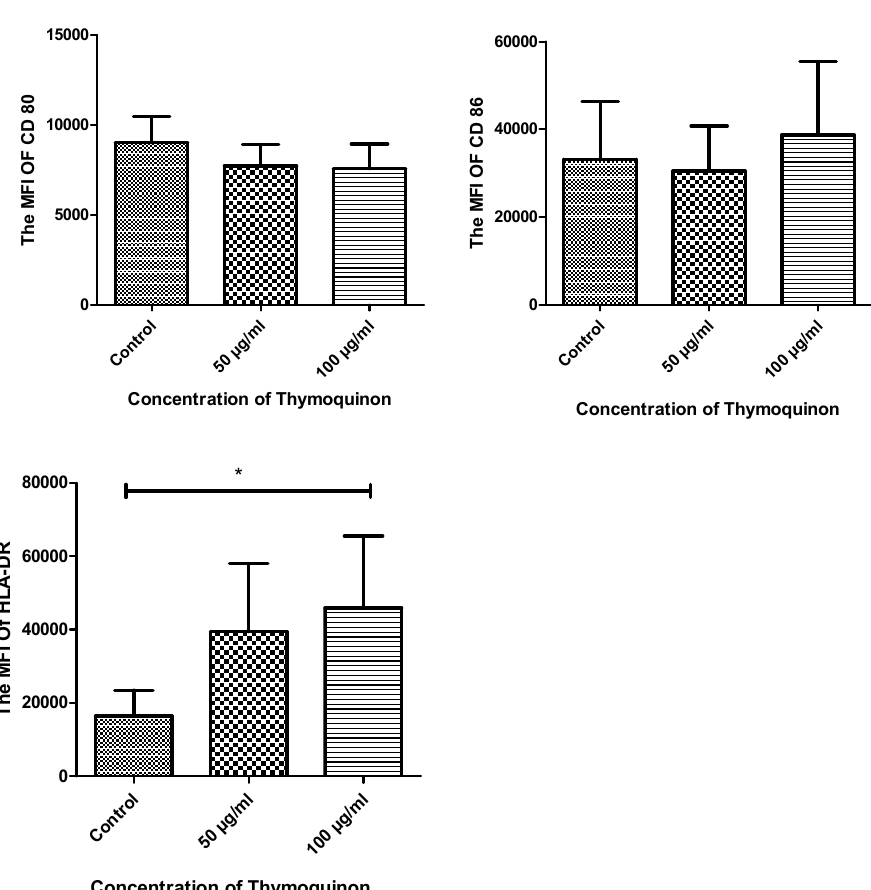
Figure 6. The MFIs of CD80, CD86 and HLA-DR expression in the three groups. The expression of cell-surface molecules on macrophages in different conditions (untreated macrophages (control), 50 µ g/mL TQ-treated macrophages and 100 µ g/mL TQ-treated macrophages) was checked using extracellular staining with CD80-PE, CD86-PE and HLA-DR APC. The TQ-treated cells showed no significant difference for both CD80 and CD86. However, a significant increase in the expression of HLA-DR compared to control was detected with the 100 µ g/mL-treated cells. p value = 0.05 and n = 5. MFI, mean fluorescence intensity; CD80, cluster of differentiation 80; CD86, cluster of differentiation 8; HLA-DR, human leukocyte antigen DR isotype; CD86 PE-A, phycoerythrin monoclonal anti cluster of differentiation 86; HDLA-DR APC-A, allophycocyanin monoclonal anti cluster of differentiation human leukocyte antigens DR. * p value ≤ 0.05.